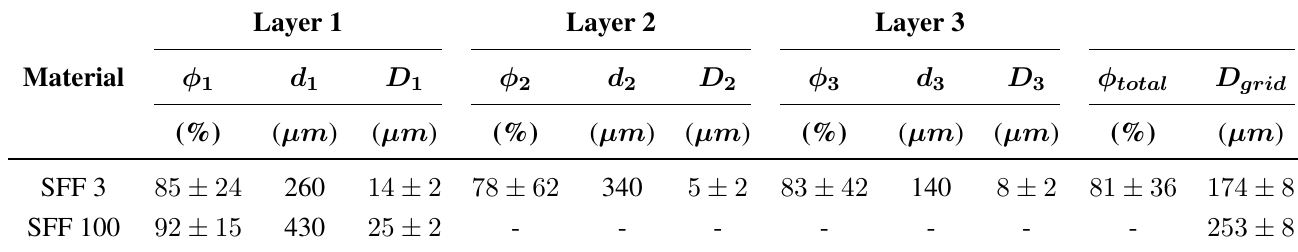
) and diameter of the wires i